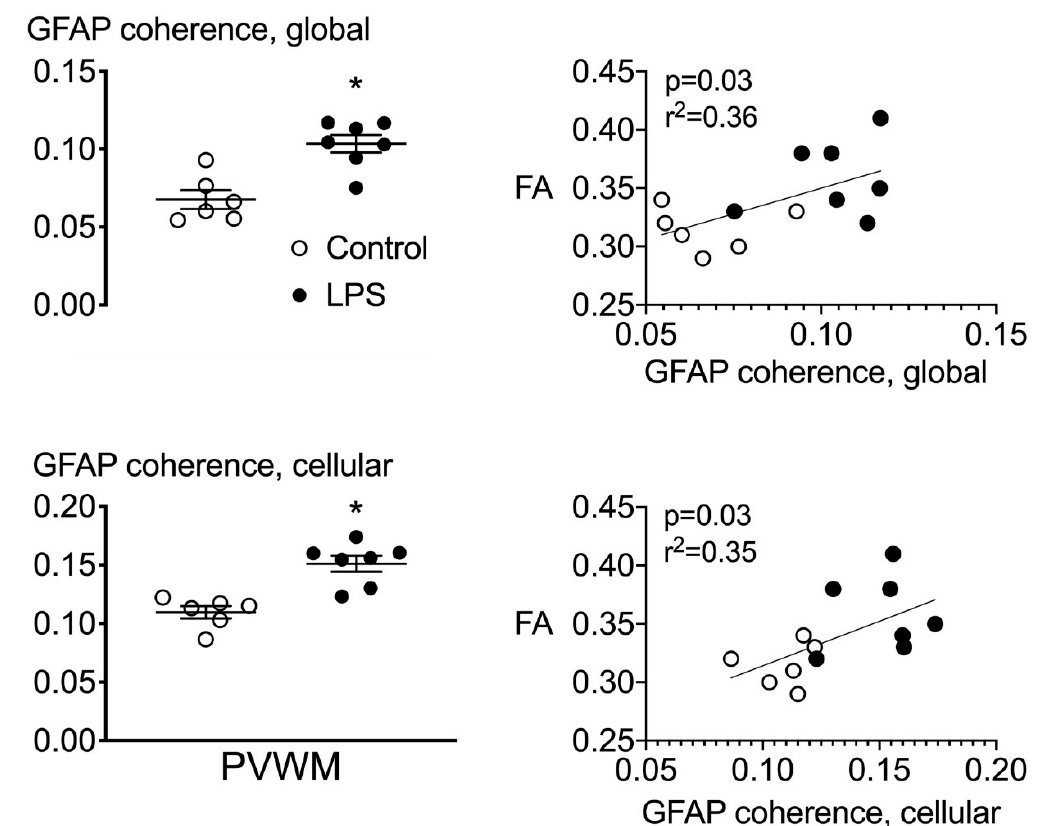
Figure 5. Astrocyte coherence. ( Left ) Astrocyte coherence in the periventricular white matter quantified from GFAP-stained histological sections. Global coherence was derived from whole periventricular white matter tissue sections. Cellular coherence represents coherence values derived from 15 randomly selected astrocytes per section. ( Right ) Correlative analyses between global and cellular coherence in the periventricular white matter from GFAP-stained tissue sections and fractional anisotropy. * p < 0.05, LPS vs. control.